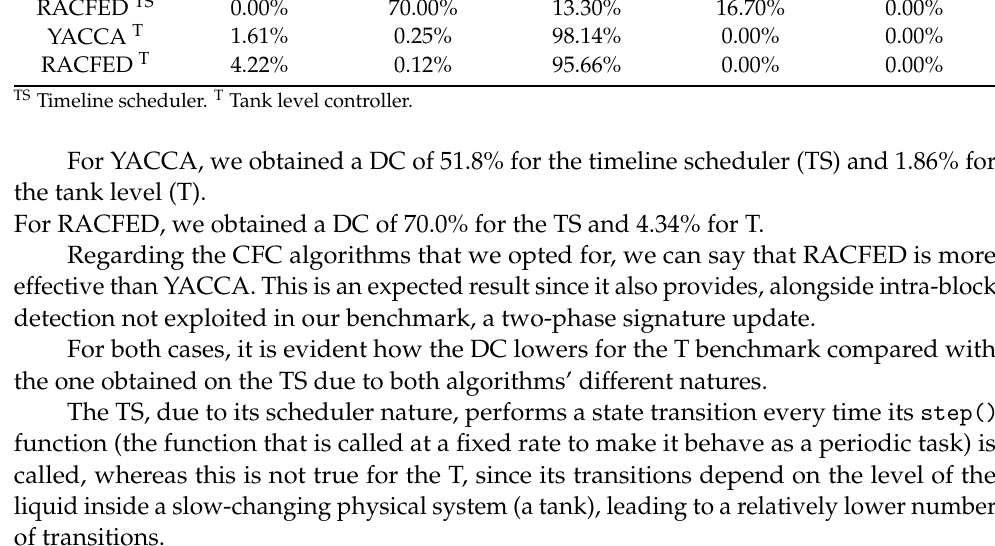
Table 7. ISO 26262-compliant classification of the results obtained from the fault injection campaign. Detected Undetected Safe Detected Latent Residual YACCA TS YACCA